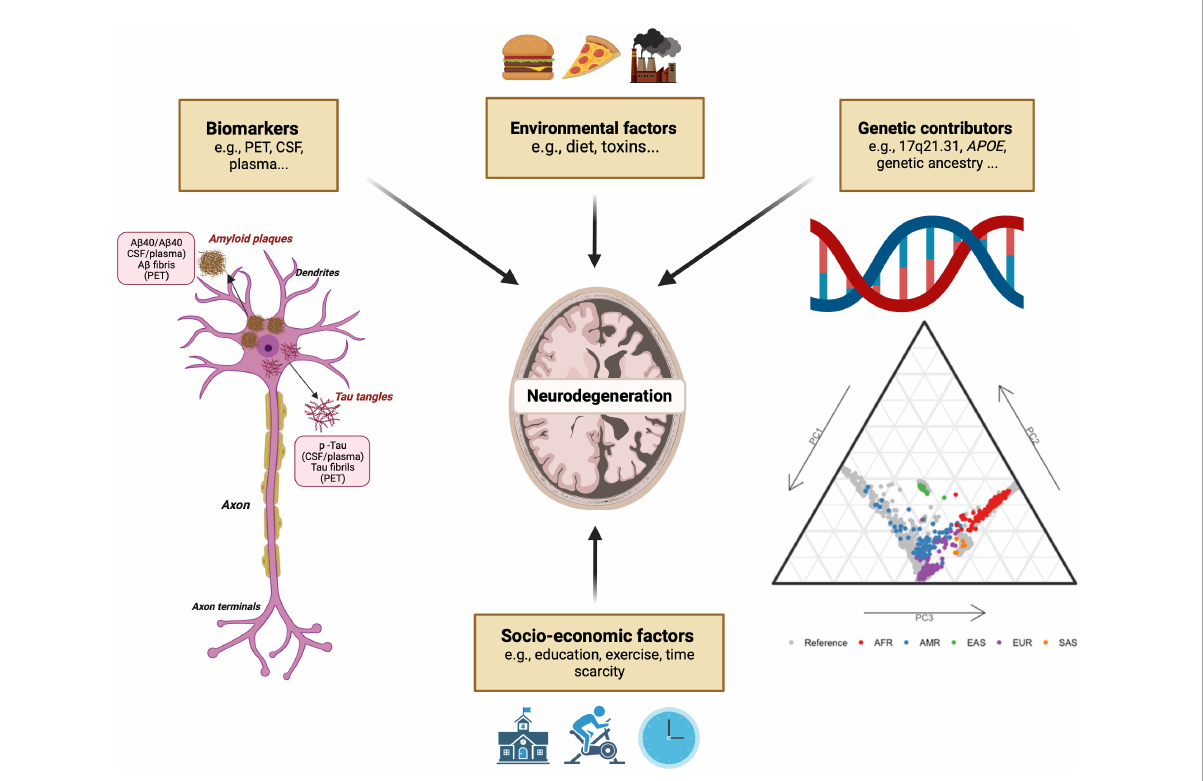
FIGURE3 Main factors implicated in neurodegenerative disease and associated fluid